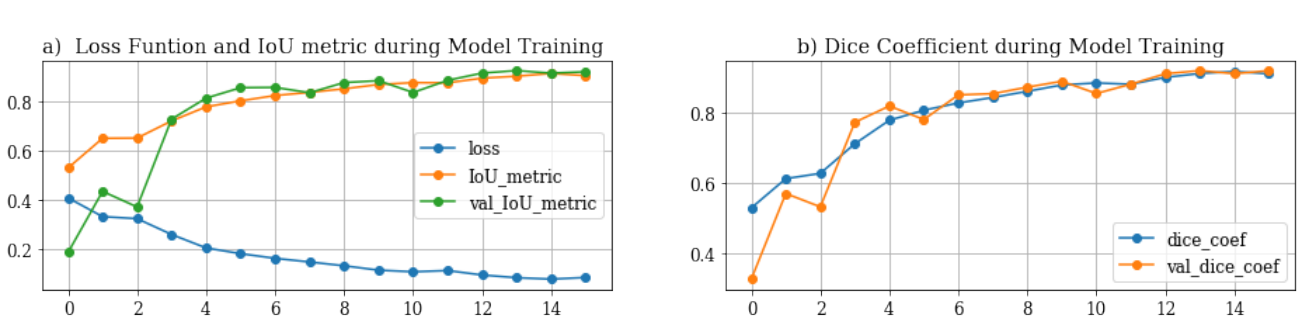
Figure 5. Performance and metrics of the FCN model using the training and validation sets.